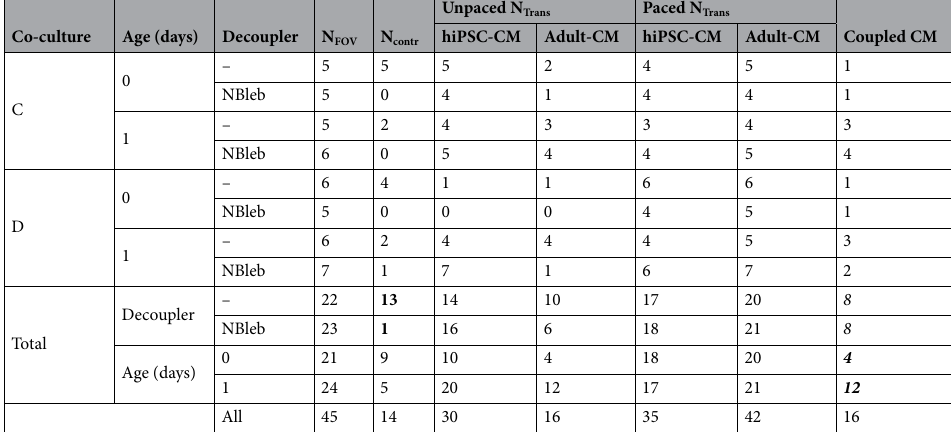
Table 1. Summary of the 3D LSFM imaging of co-culture with and without NBleb. For each of the two co-cultures (referred to as C & D), two samples were imaged on the starting day of co-culture (day 0), while the other two were imaged the following day (day 1). Decoupling with para-nitroblebbistatin is indicated by “NBleb”, with “–” indicating no decoupler used. The number of unique FOVs containing adult-CM imaged within each co-culture sample is indicated by N FOV , and N contr indicates how many FOVs with those adult-CM contained cells contracting during the acquisition. The next six columns indicate how many of the N CM contained hiPSC-CM and adult-CM underwent calcium transients in unpaced vs paced image acquisitions. Finally, the last column indicates how many out of the N CM for each sample are considered coupled according to the criteria discussed above. While there were more adult-CM contracting in control samples, compared to those treated with NBleb (bold highlight) the number of coupled adult-CM was the same (italic highlight). Overall, the number of coupled CM was higher by day 1 of co-culture, compared to day 0 (bold italic